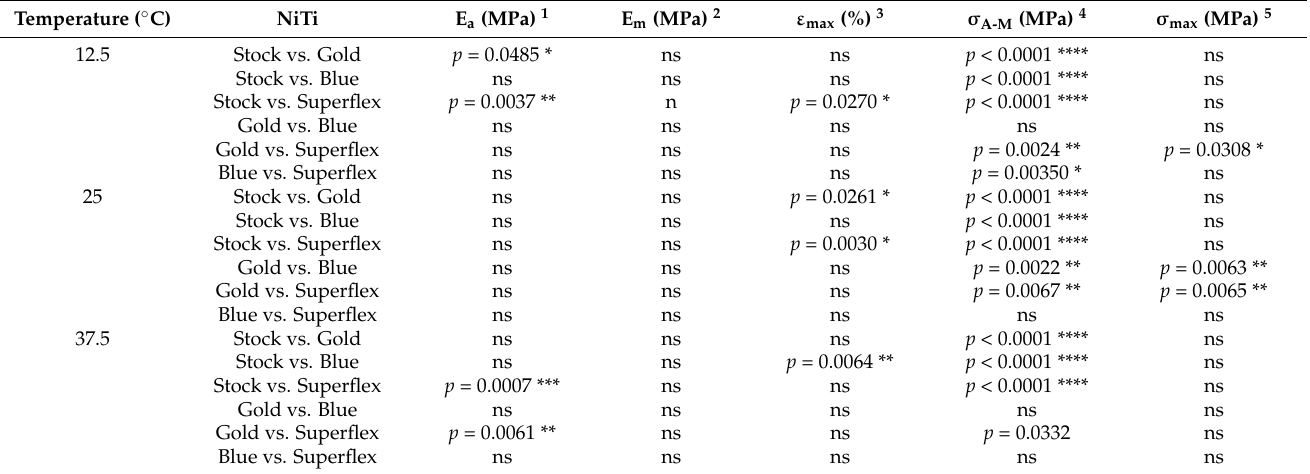
Table 4. Multiple statistical comparisons for the influence of sample type. This table shows results for Tukey’s multiple comparisons comparing E a , E m , ε max , σ A-M , and σ max at the same temperature for different alloys. Significant outcomes are summarised as follows: * = p < 0.05; ** = p < 0.01; *** = p < 0.001; **** = p <